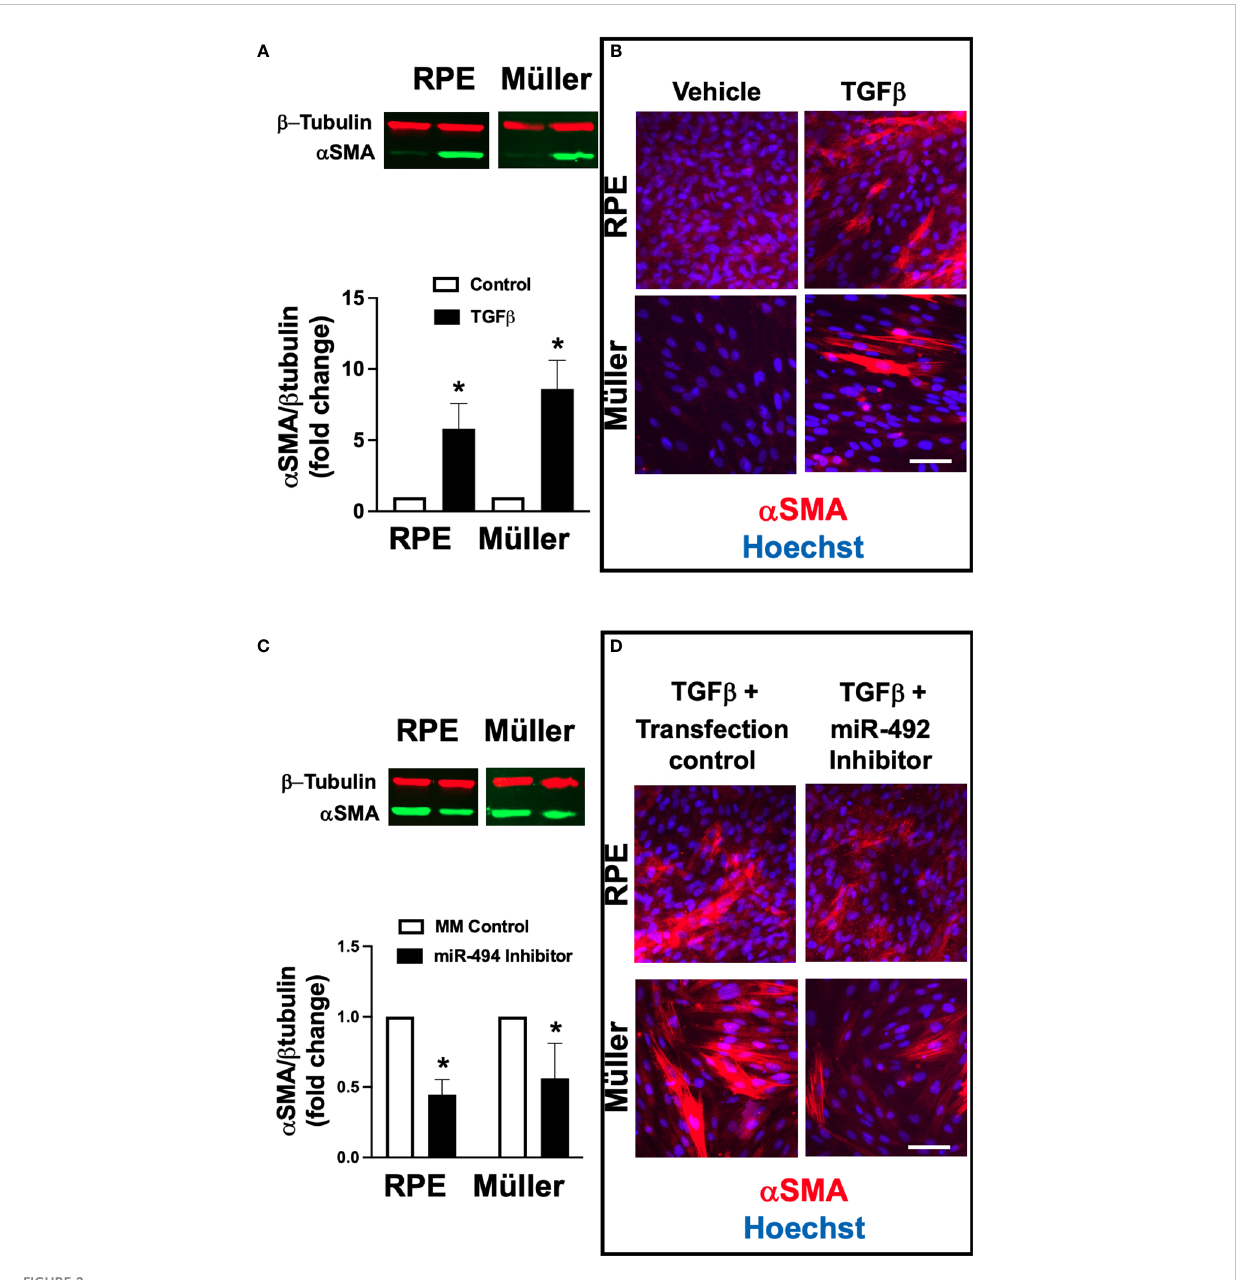
FIGURE 2 Effect of alpha smooth muscle actin ( a SMA) expression after TGF b stimulation with and without miR-494 inhibition in human Müller cell line and human RPE cell lines. (A) Quanti fi cation of a SMA in human RPE and Müller cell lines by immunoblot (representative blots above) with and without 72h TGF b treatment. (B) Representative immuno fl uorescent images of a SMA (red) in human RPE and Müller cell lines with and without 72h TGF b treatment and counterstained with the nuclear dye 4 ′ ,6-diamidino-2-phenylindole (DAPI, blue). (C) Quanti fi cation of a SMA in human RPE and Müller cell lines by immunoblot (representative blots above) after 72h TGF b treatment with and without pre-treatment and co-incubation with miR-494-3p inhibitor. (D) Representative immuno fl uorescent images of a SMA (red) in human RPE and Müller cell lines counterstained with the nuclear dye DAPI (blue) after 72h TGF b treatment with and without pre-treatment and co-incubation with miR-494-3p inhibitor. Mean ± SEM, * p<0.05 TGF b versus control